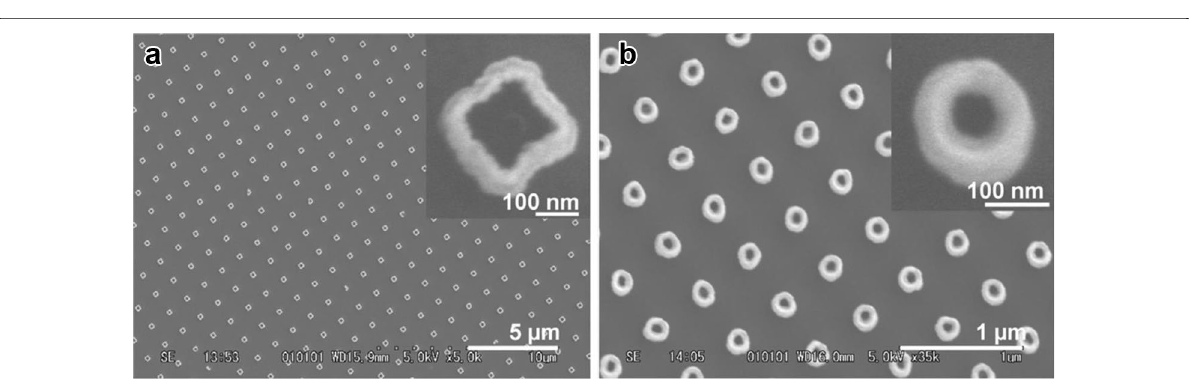
Fig. 6 SEM images of different 3D Au hollow nanostructures. a Au nanobox arrays with 65 nm inside pores were made using 200 nm square and 100 nm circular pattern molds, respectively ∼